Question: Name the type of graph shown.
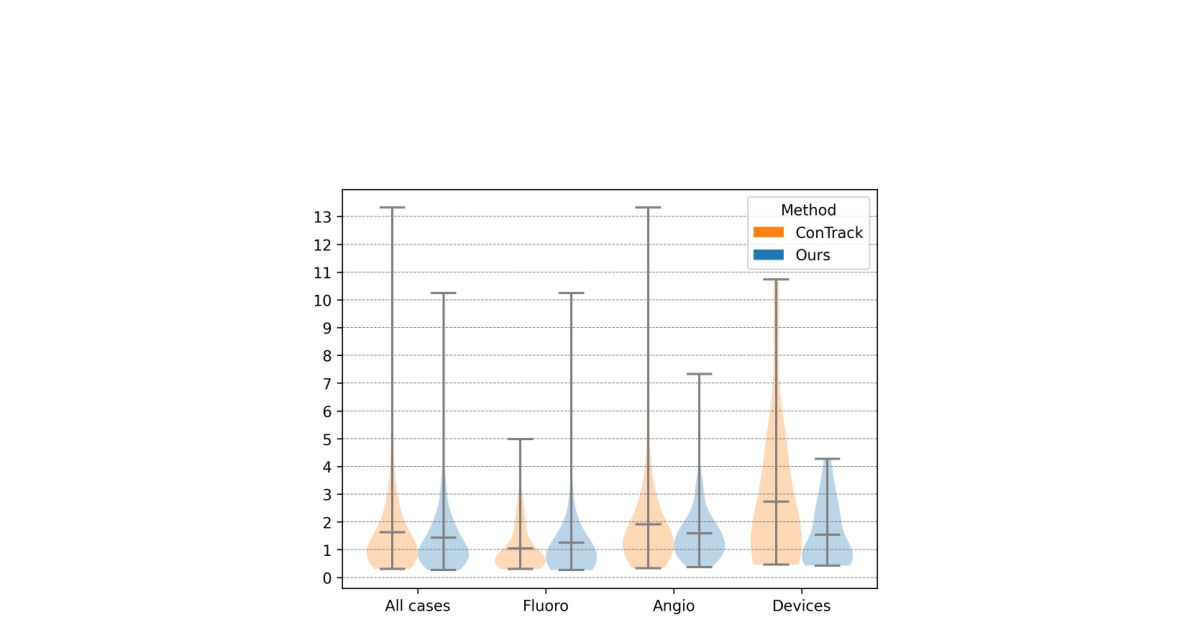
Answer: box